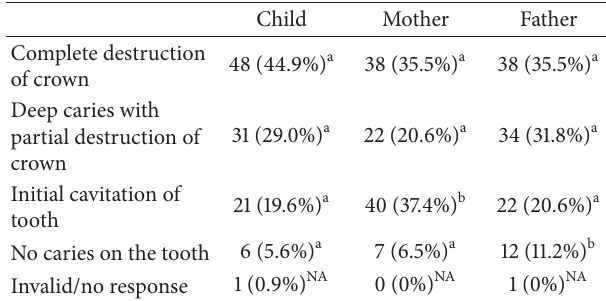
Table 3: Point at which the population would visit the